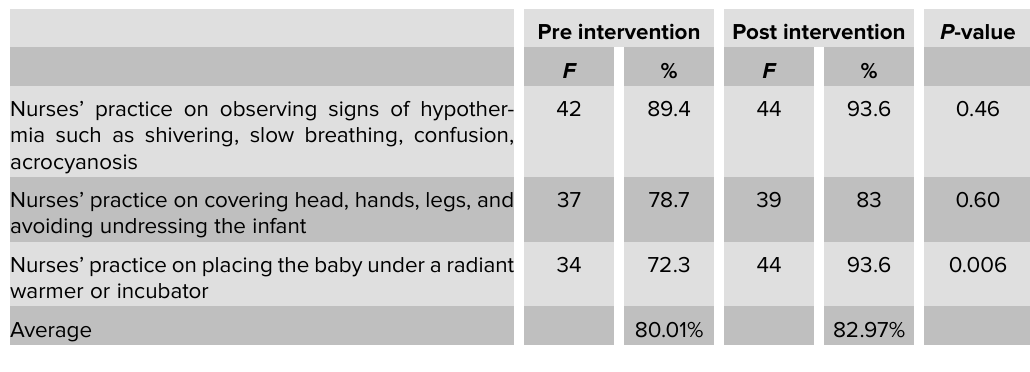
Table 2: Nurses’ practice of hypothermia management ( n =